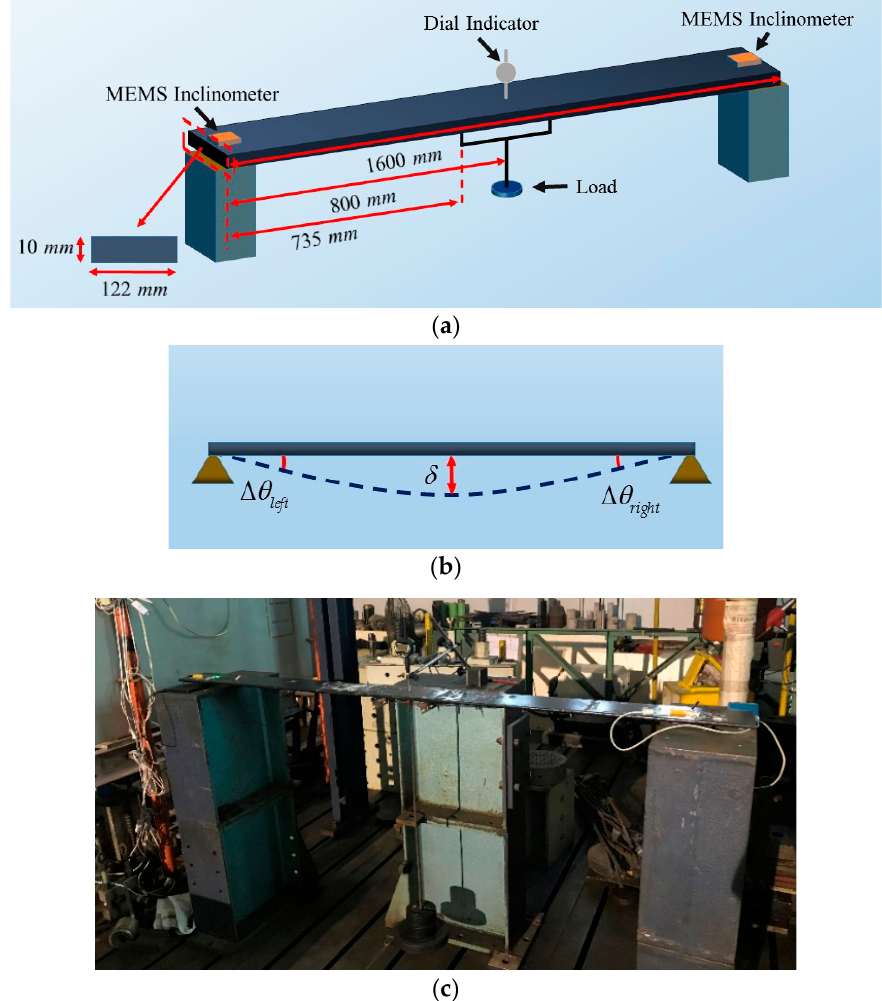
Figure 13. The setup for the deflection experiment. ( a ) A schematic diagram of the experimental setup; ( b ) an illustration of the δ which is measured in the experiment; ( c ) the front view of the setup.